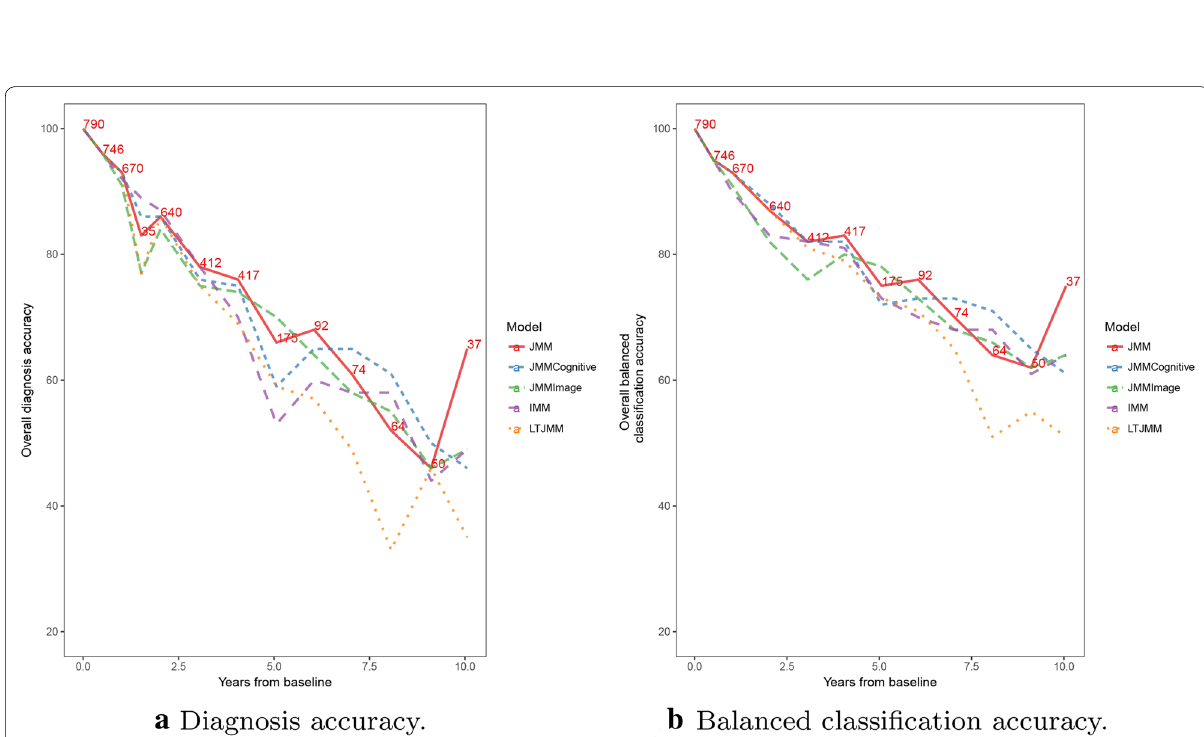
Fig. 12 Comparison of performance metrics on clinical status for subset of the population with amyloid burden information. Note that only the LTJMM did not include baseline diagnosis as a covariate. The numbers on the graph represent the number of subjects at each of the